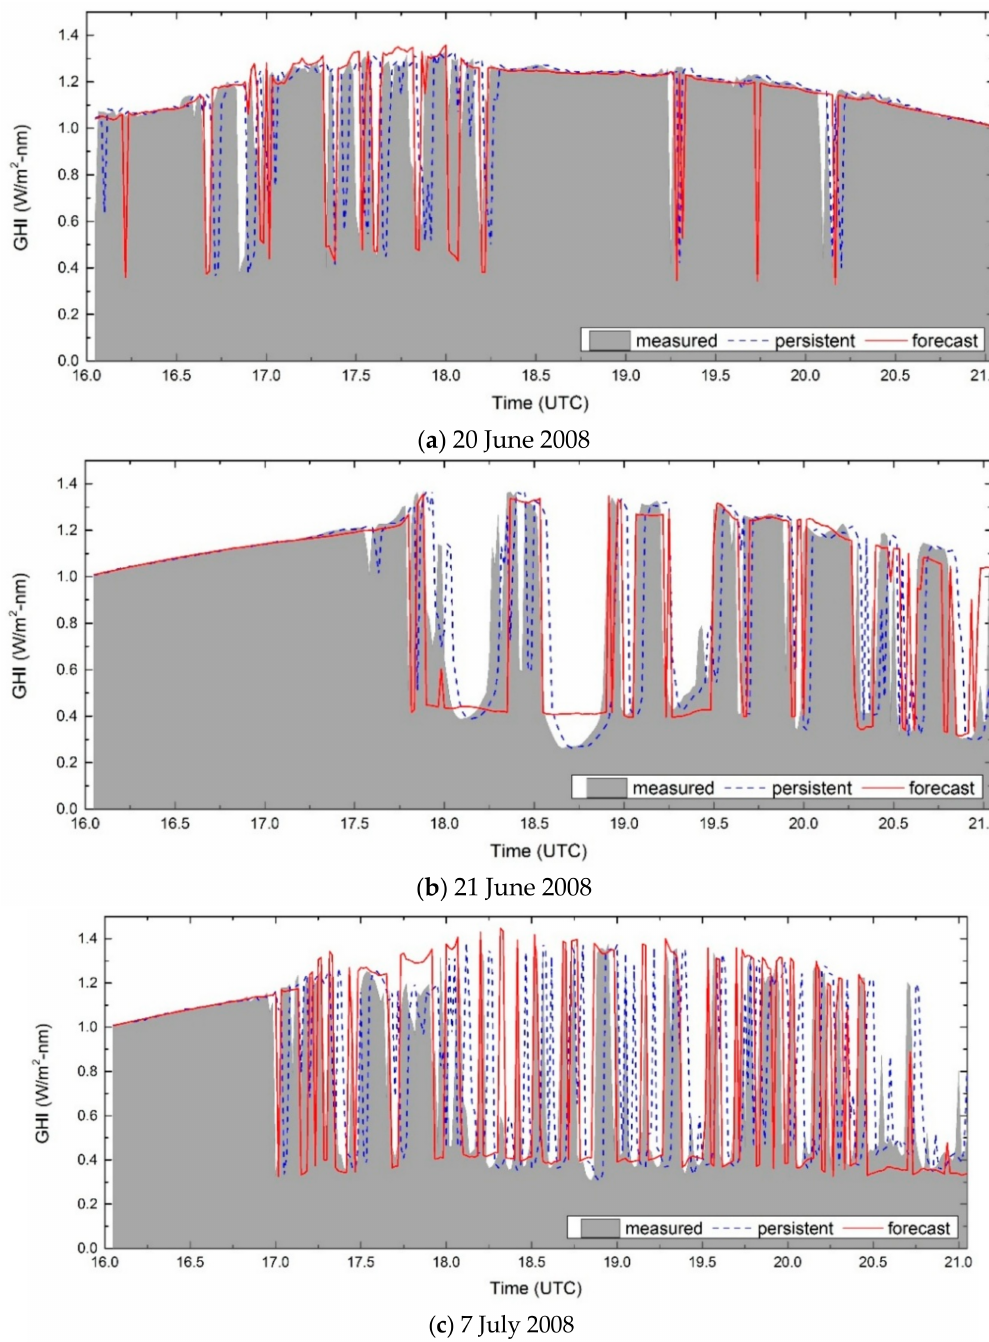
Figure 7. 3-min ahead forecasting of 1-min GHI values for the 3 days evaluated. The time-series range from 16:00 to 21:00